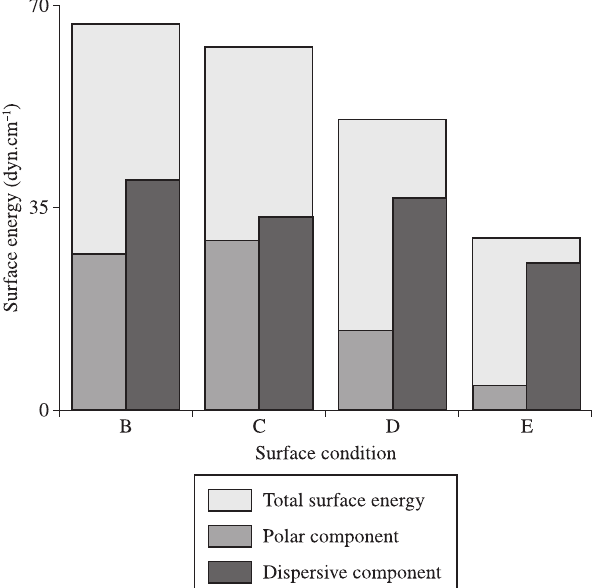
Figure 3. Free energy of glass surfaces under different conditions. In B, the surface was sonicated in detergent and water baths; in C, the surface was coated by PECVD of heparin/isopropanol at an rf power of 25 W; in D, the glass was exposed to SF